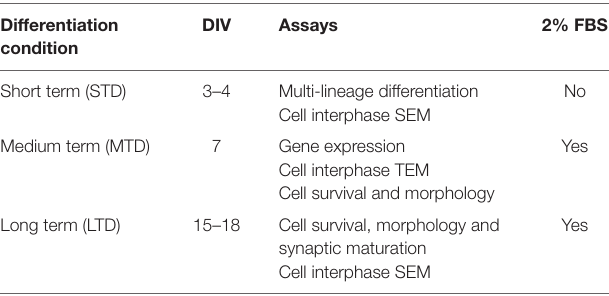
TaBle 1 | Protocols used to differentiate aOBscs and the assays